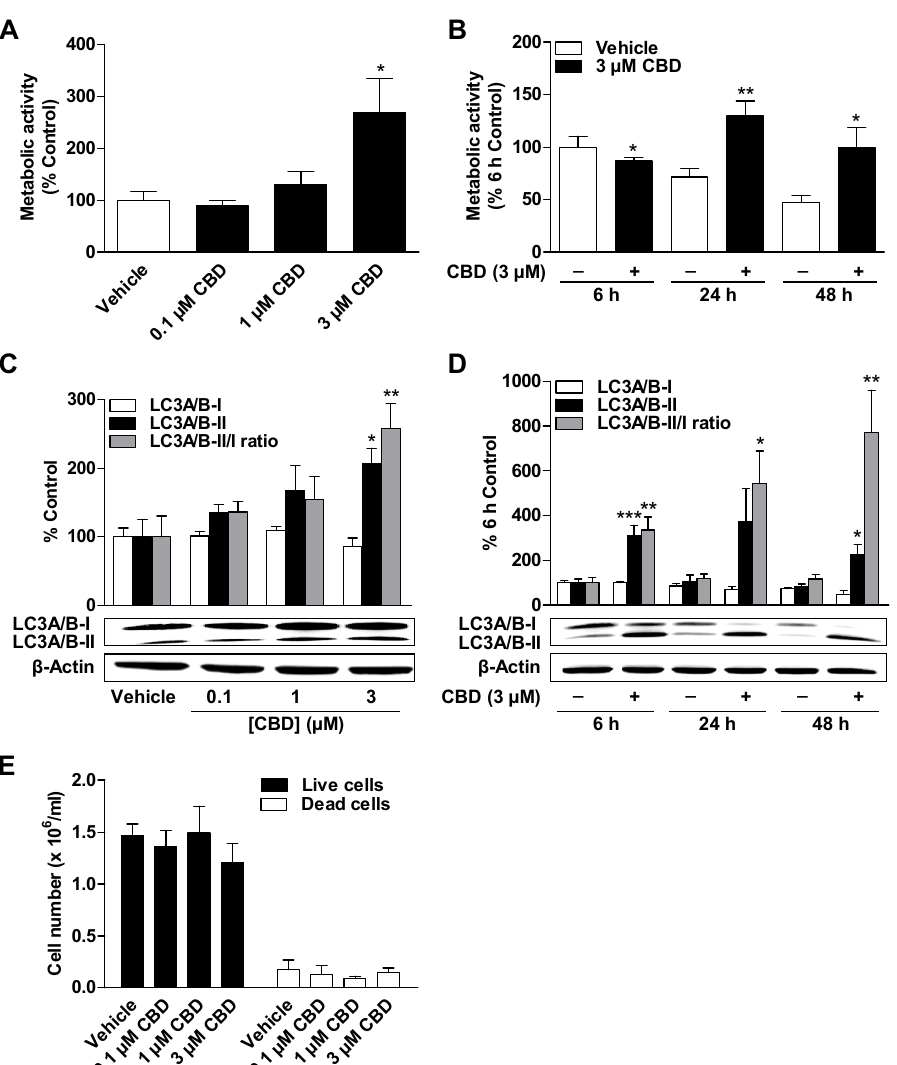
Figure 2. Concentration- and time-dependent effect of CBD on metabolic activity, autophagy, and cell count of ADMSCs. The cells were incubated with the indicated concentration of CBD or vehicle for 24 h ( A , C , E ) or with 3 µM CBD or vehicle for the specified times ( B , D ). After incubation, the cells were analyzed for their metabolic activity by WST-1 assay ( A , B ), for their LC3A/B-I/II protein expression by Western blot analysis ( C , D ), and for their cell count ( E ) by trypan blue staining. The protein expression values were normalized to β -actin. The percentage control represents a comparison with the time-matched vehicle-treated cells ( A,C ) or the cells treated with vehicle for 6 h ( B , D ). The data represent mean values ± SEM of n = 6–8 ( A ), n = 5 ( C ), n = 7 ( B , D ), or n = 3 ( E ) different donors. * p < 0.05, ** p < 0.01, *** p < 0.001 vs. time-matched vehicle; one-way ANOVA with Dunnett’s post hoc test ( A , C ) or Student´s t test ( B , D ).